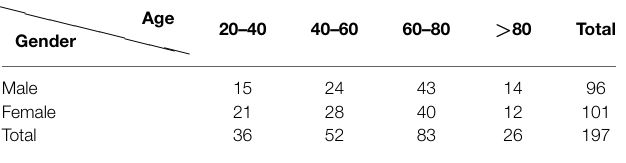
TABLE 2 | Frequency of ESBL Isolates by age.